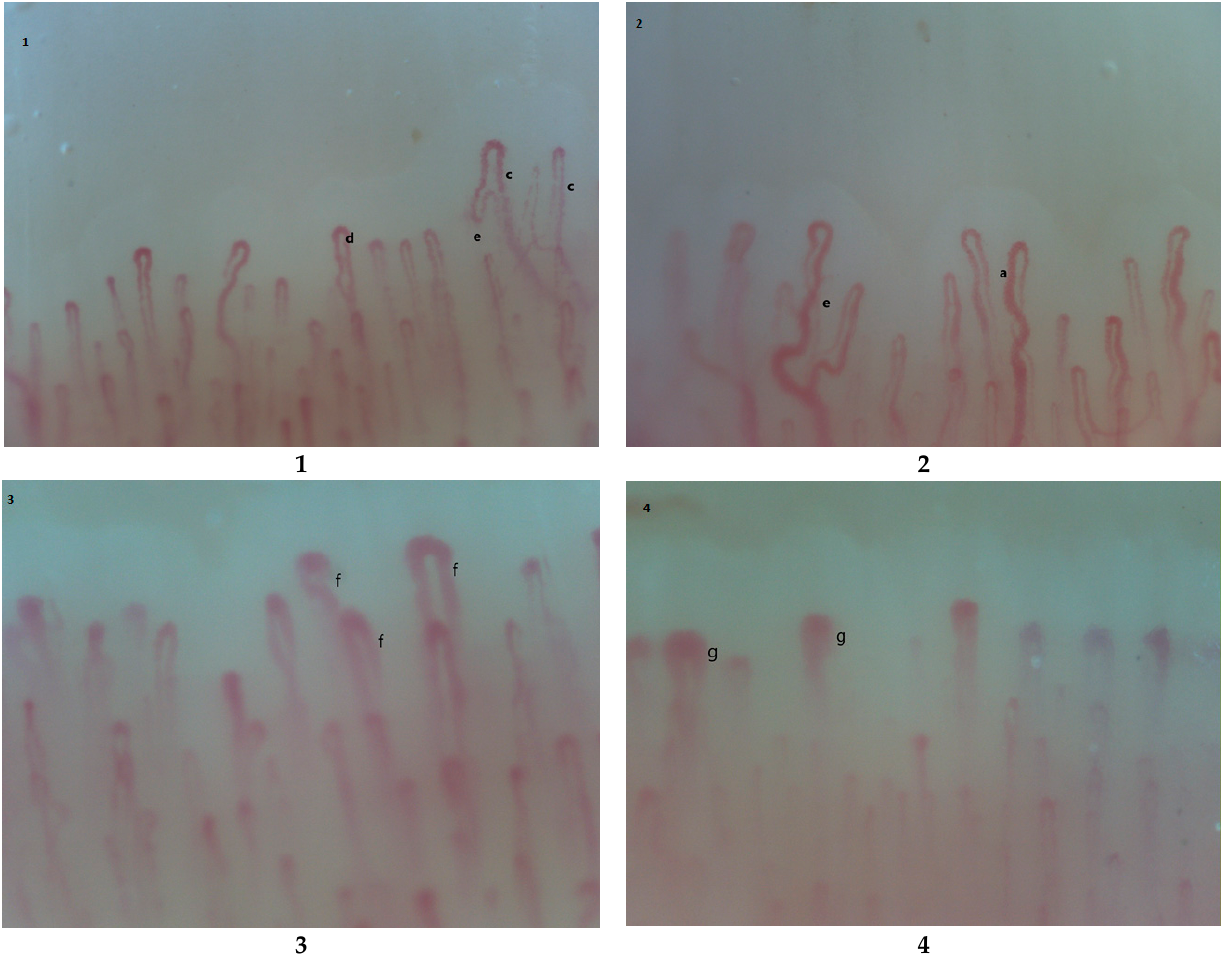
Figure 1. Possible capillaroscopic findings in AN [8,9]. 1 . Aspecific pattern: c. plasma gaps, d. apical ectasias(dilatation), e. morphological anomalies; 2 . Aspecific pattern: a. increase in the afferent/efferent capillar loop ratio, e. morphological anomalies (crossings and tortuosity); 3 . Early scleroderma pattern f. capillary ectasias; 4 . Early scleroderma pattern g. megacapillaries.